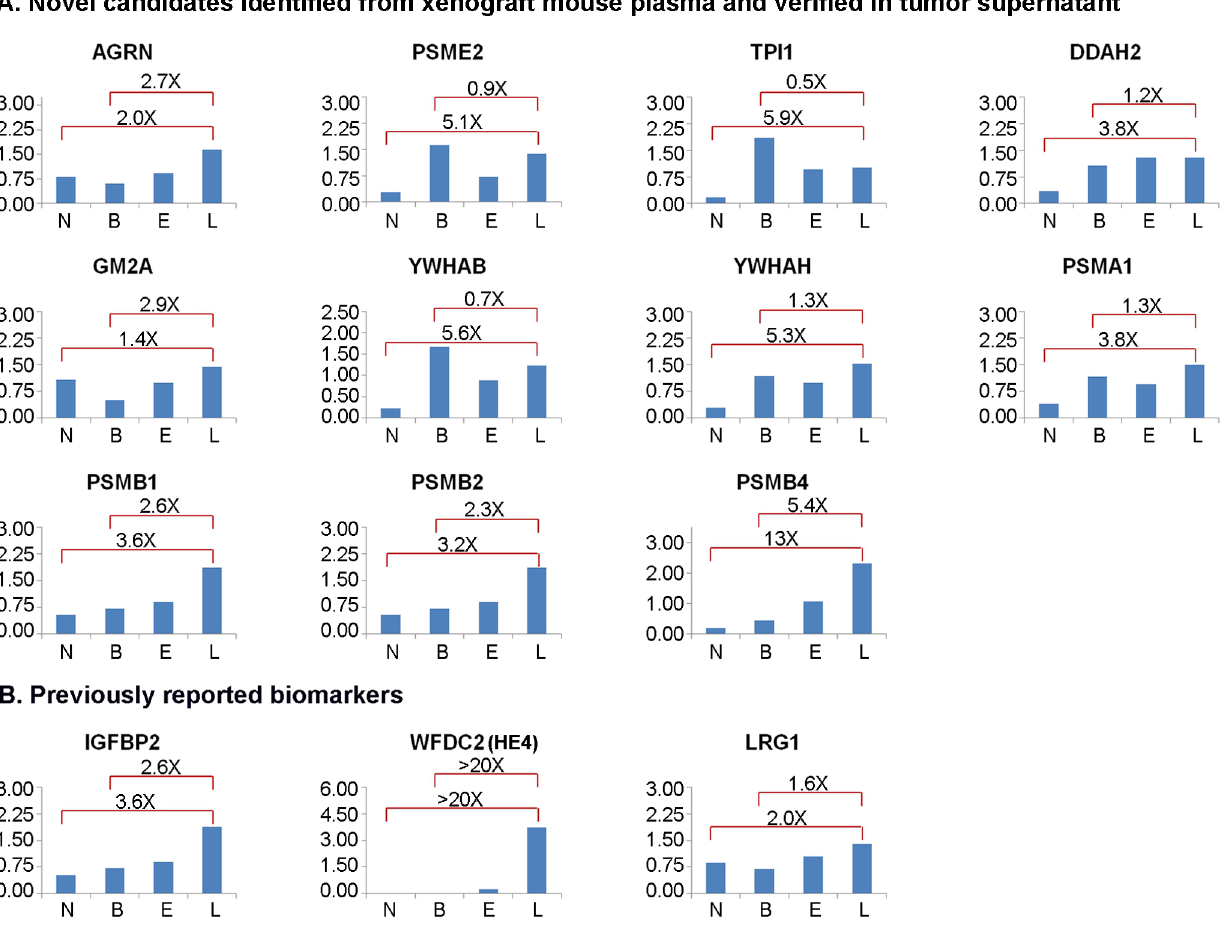
Figure 6. Verification of promising candidate biomarkers using a label-free MRM assay. Normalized relative protein amounts are shown for serum pools of normal (N; n=9), benign (B; n=10), early-stage ovarian cancer (E; stages 1 and 2; n=18), and late-stage ovarian cancer (L; stage 3; n=29). Ratios of late-stage cancer to benign disease and normal donors are shown above the histograms. (A) The 11 novel high priority biomarkers from the 15–50 kDa region of the gel. (B)Three previously reported biomarkers included as references and analyzed in parallel with the novel biomarkers.